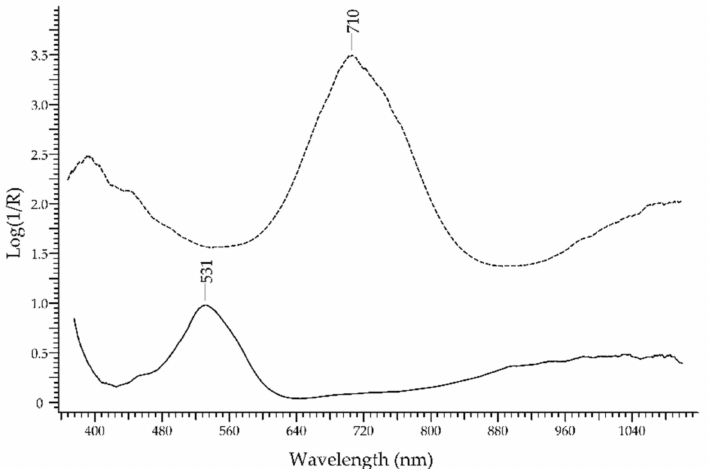
Figure 19. FORS spectrum in Log(1/R) coordinates of a rubellite variety (solid line) and a green tourmaline (dashed